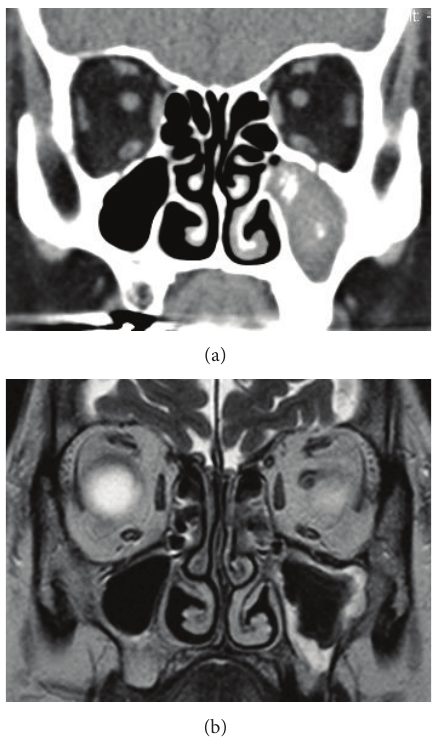
Figure 2: Representative case of fungus ball identifiable only on MR imaging. (a) Coronal CT scan with soft tissue density. Left maxillary sinus is filled with material. Irregular surface of the material suggests the possibility of fungus ball. High density spot is not seen. (b) Coronal T2-weighted MR image. Extremely low signal intensity to signal void indicates the presence of fungus